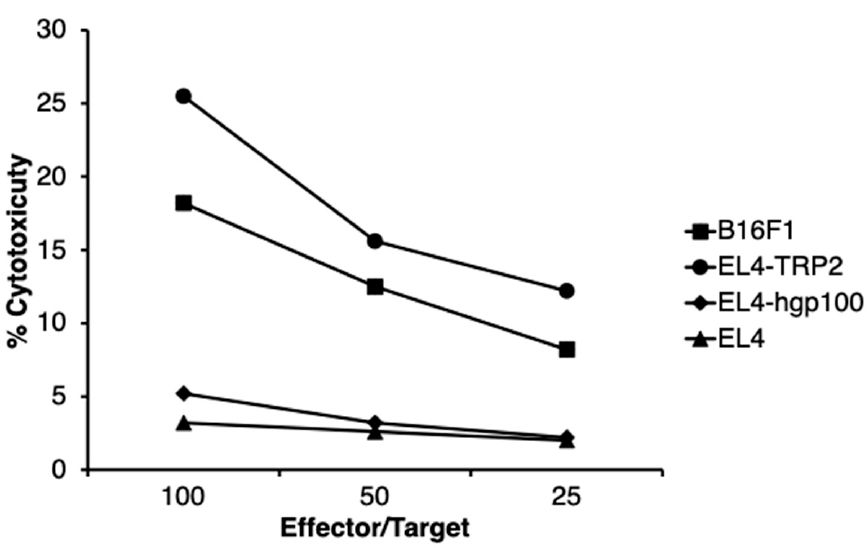
Figure 6. Induction of CTLs against B16F1 cells and TRP2 peptide by combination therapy that used intratumoral administration of N -Pr-4- S -CAP and BMDCs as determined by 51 Cr release assay. Mice were treated with N -Pr-4- S -CAP and BMDCs combination therapy, and then spleen cells were harvested from mice that were completely cured and re-stimulated with irradiated B16F1 cells for 5 days. Cytotoxic activity of spleen effector cells against B16F1cells, EL4 cells, EL4 cells coated with TRP-2 peptide or YAC-1 cells was determined by a standard 51 Cr release assay.